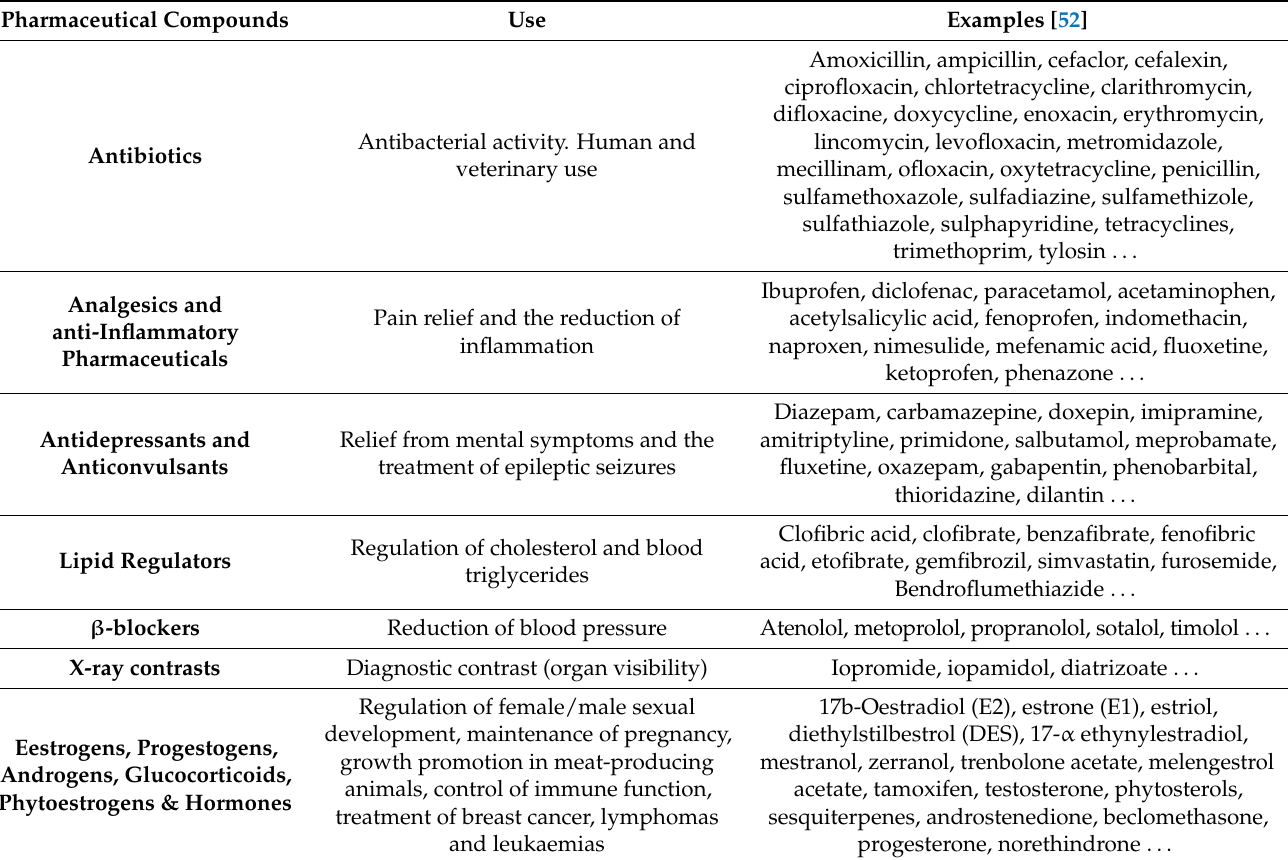
Table 2. Classification and functions of pharmaceutical